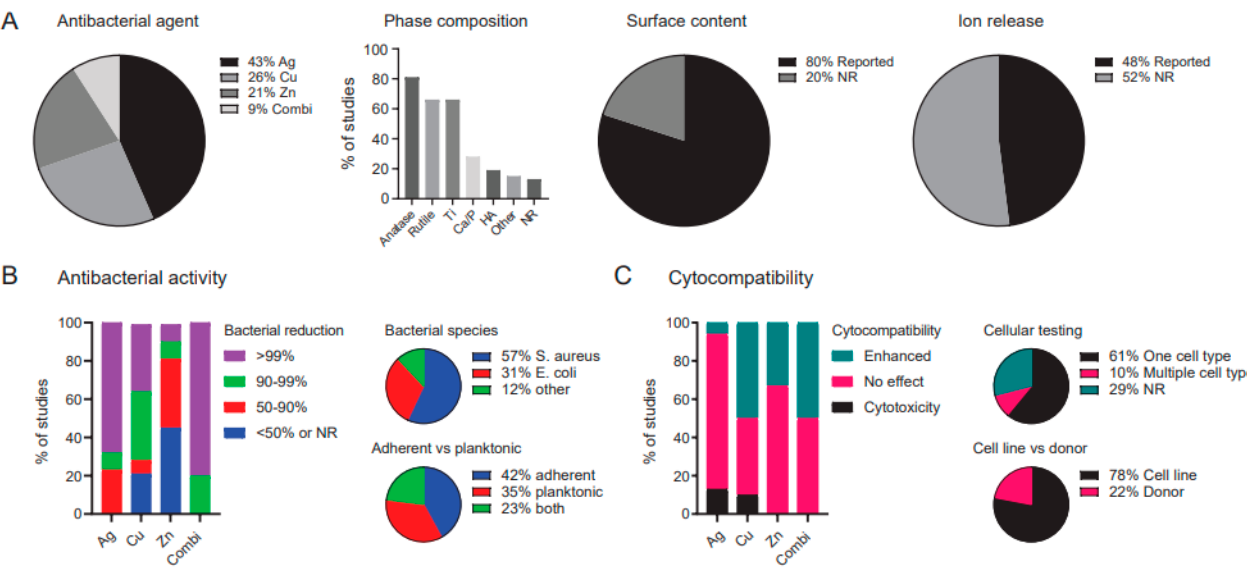
Figure 2. An overview of the ( A ) biomaterial, ( B ) antibacterial, and ( C ) cytocompatibility specifications of the studies included in this systematic review of the literature. Combi: combination of Ag, Cu, and/or Zn, HA: hydroxyapatite, NR: not reported.